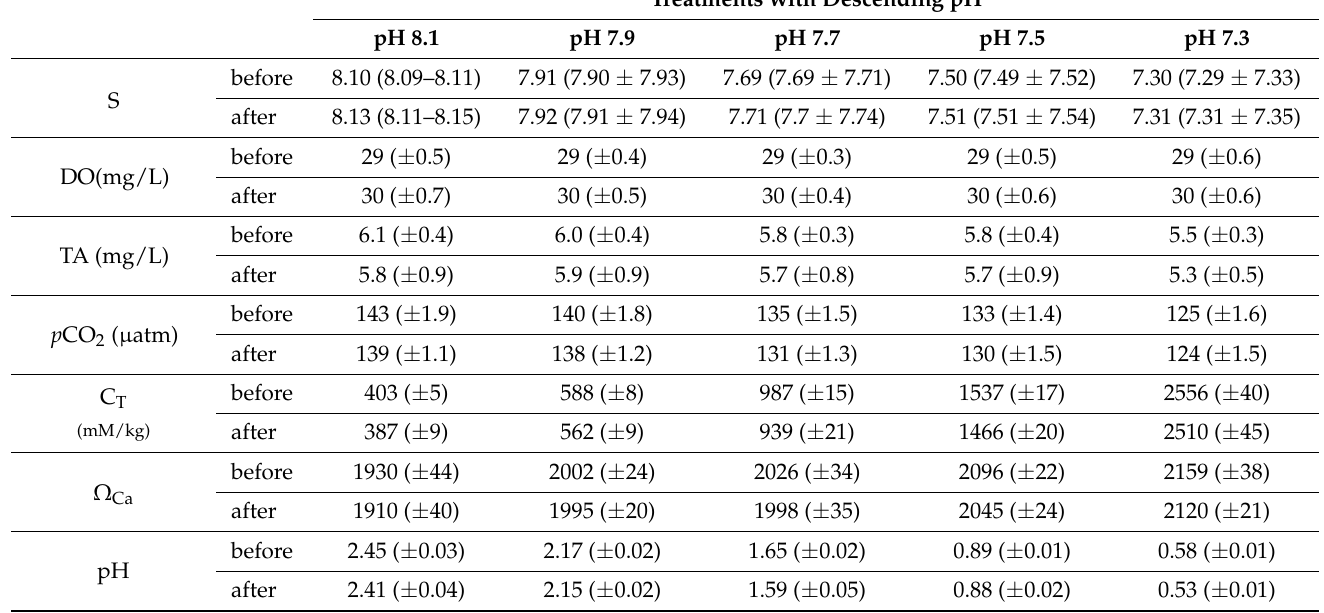
Table 2. Environmental parameters of the treatment groups before and after water renewal during the experiment. The pH (NBS scale), temperature (T), salinity (S), dissolved oxygen (DO), and total alkalinity (AT) were measured. All other values (partial pressure of carbon dioxide: p CO 2 ; total dissolved inorganic carbon: C T ; and calcium carbonate saturation state for calcite: Ω Ca were calculated using CO2Sys from pH and total alkalinity. The pH values represent means [n = 30 for the treatments with constant pH; n = 10 for the treatment with descending pH] (maximum value − minimum value). The values of salinity, dissolved oxygen, total alkalinity, and other calculated factors represent means [ ± standard deviation (SD); n = 10] for the treatment with descending pH.